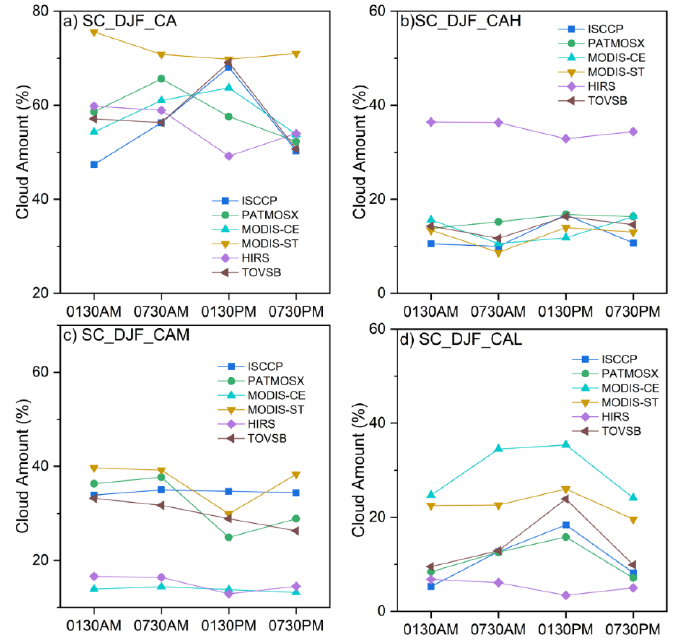
Figure 7. ( a ) Total cloud amount (CA), ( b ) high-level cloud amount (CAH), ( c ) mid-level cloud amount (CAM), and ( d ) low-level cloud amount (CAL) retrieved at four observation times for six satellite datasets in winter over south China, unit: %. The observation times of PATMOSX, MODIS- CE, MODIS-ST, HIRS, and TOVSB are 01:30, 07:30, 13:30, and 19:30 local time, and the observation times of ISCCP are 03:00, 09:00, 15:00, and 21:00 local time.